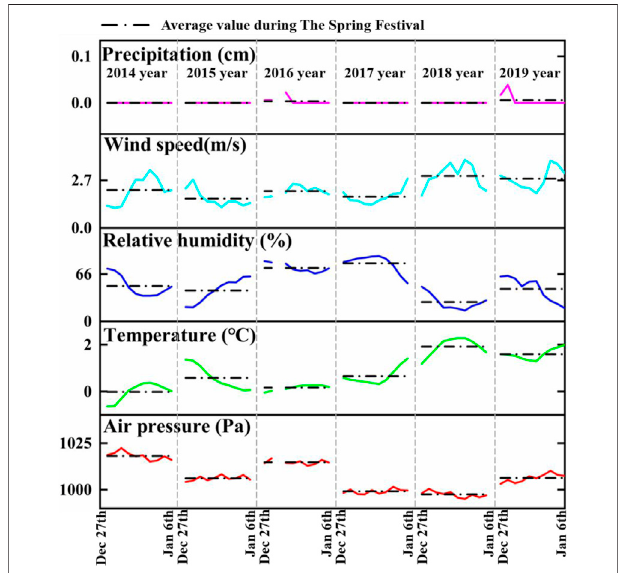
FIGURE 7 | Various meteorological elements change trend of Zhengzhou during Spring Festival half month from 2014 to